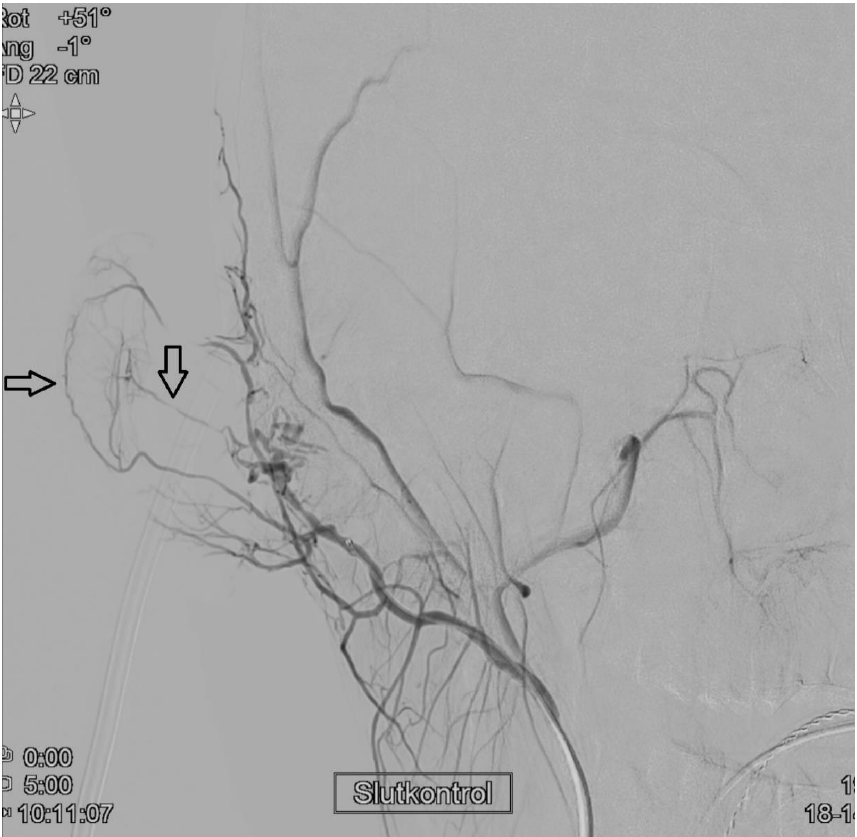
Figure 4. Postembolization angiography. A control DSA with injection in the right external carotid artery (AP-projection) showing a good angiographic result of the tumor embolization, with contrast filling of arterial branches to the external ear (arrows).